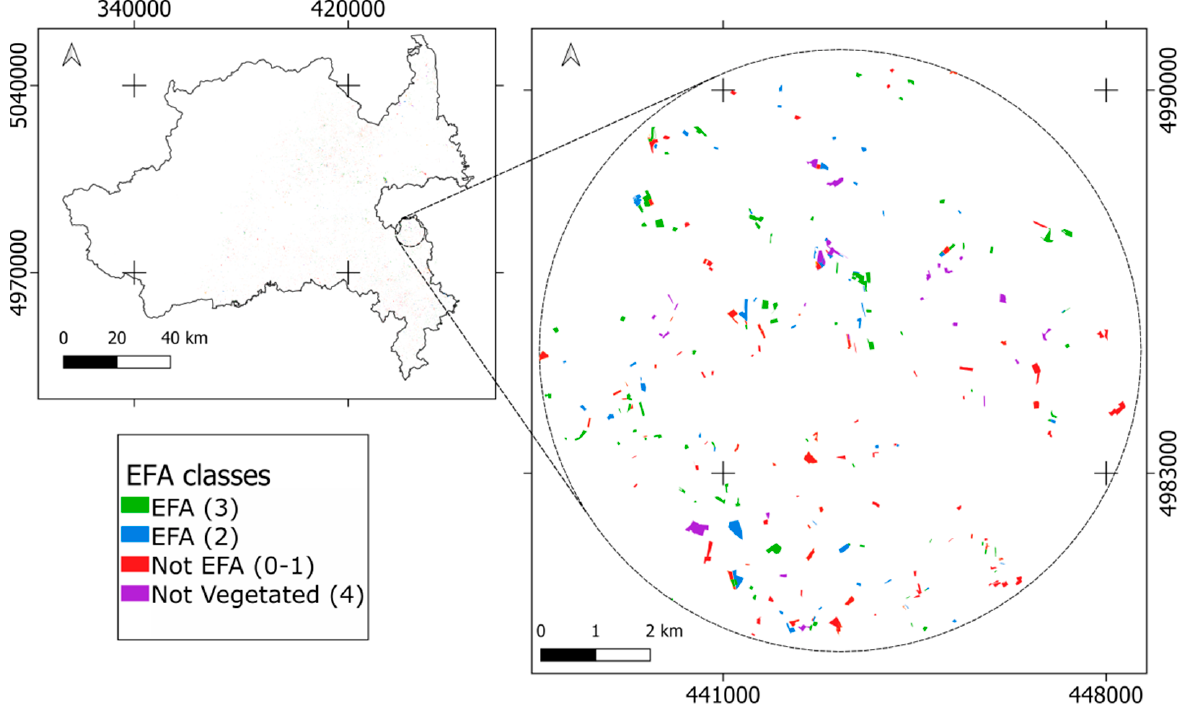
Figure 6. EFA map. (Reference system is WGS84/UTM 32N, EPSG: 32632). Table 5. Number of plots and corresponding area of the classes mapped within the EFA map.